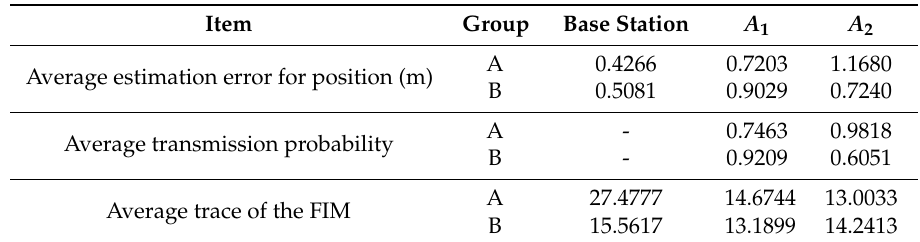
Table 5. Comparison of the average estimate errors, the average transmission probabilities, and the average trace of the FIM in Scenario 2 (Group A vs. Group B).